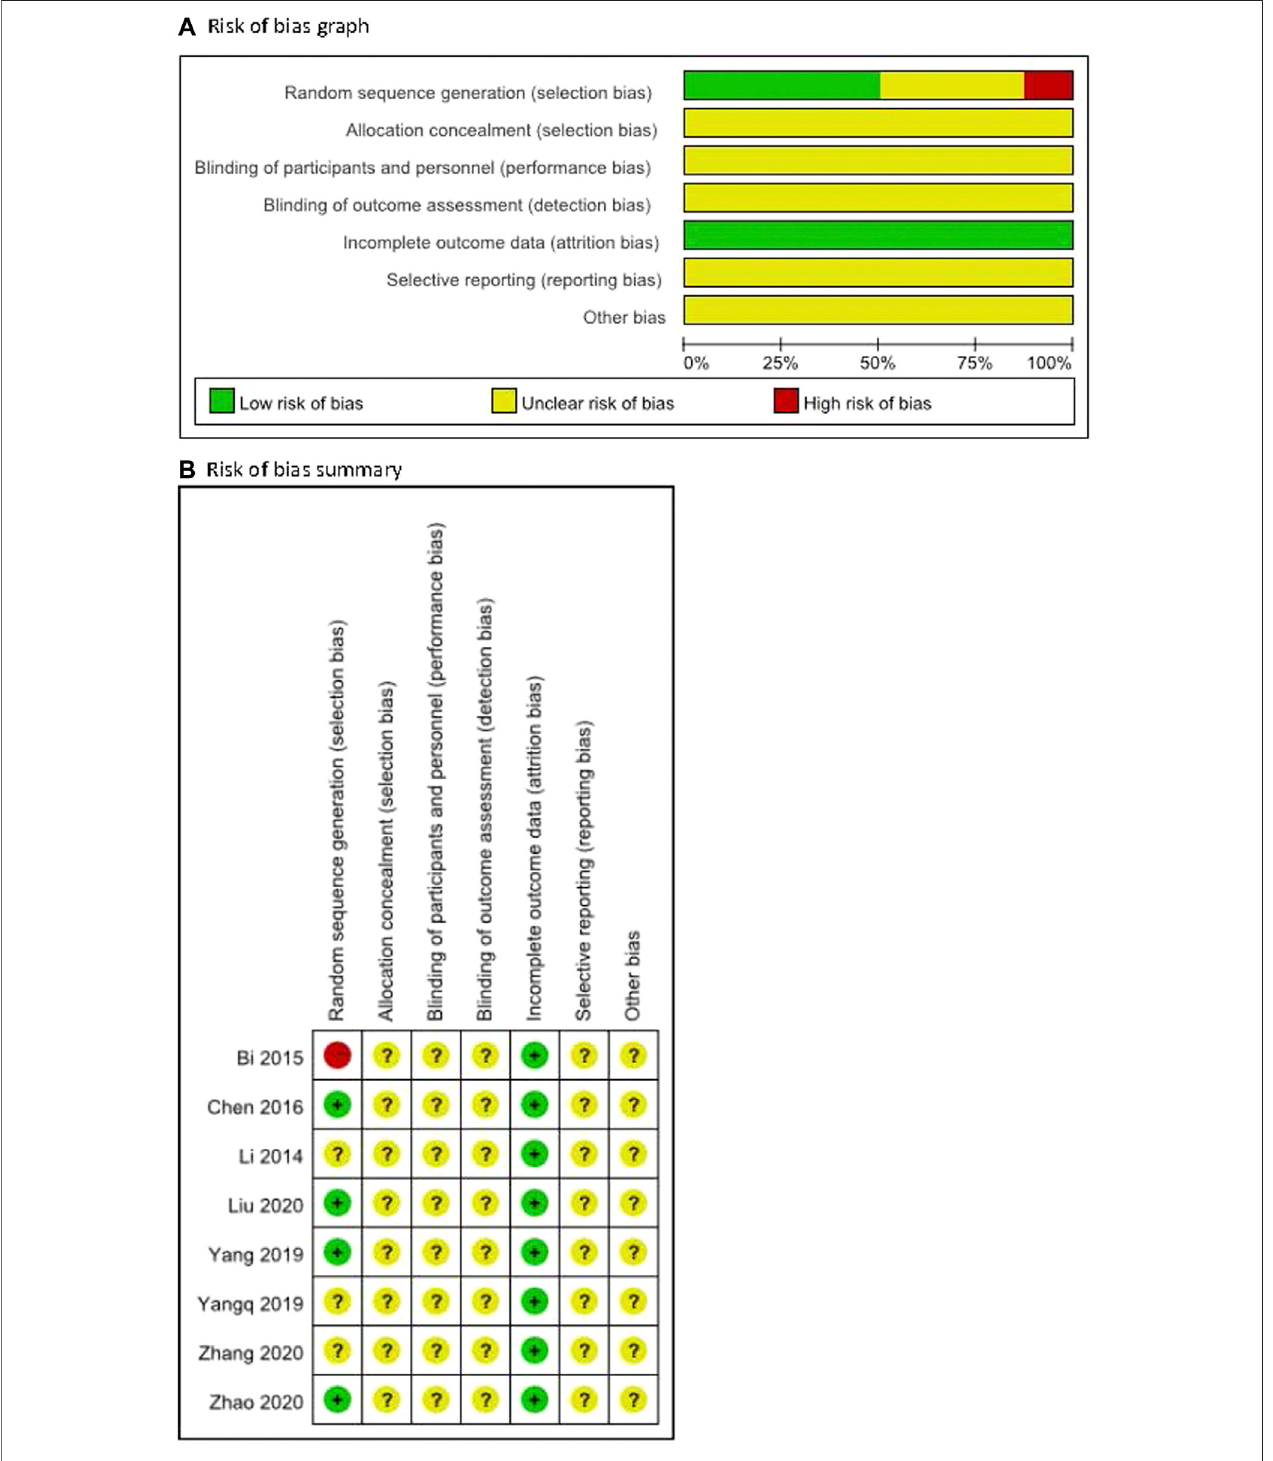
FIGURE 2 | Risk of bias of the including trials.